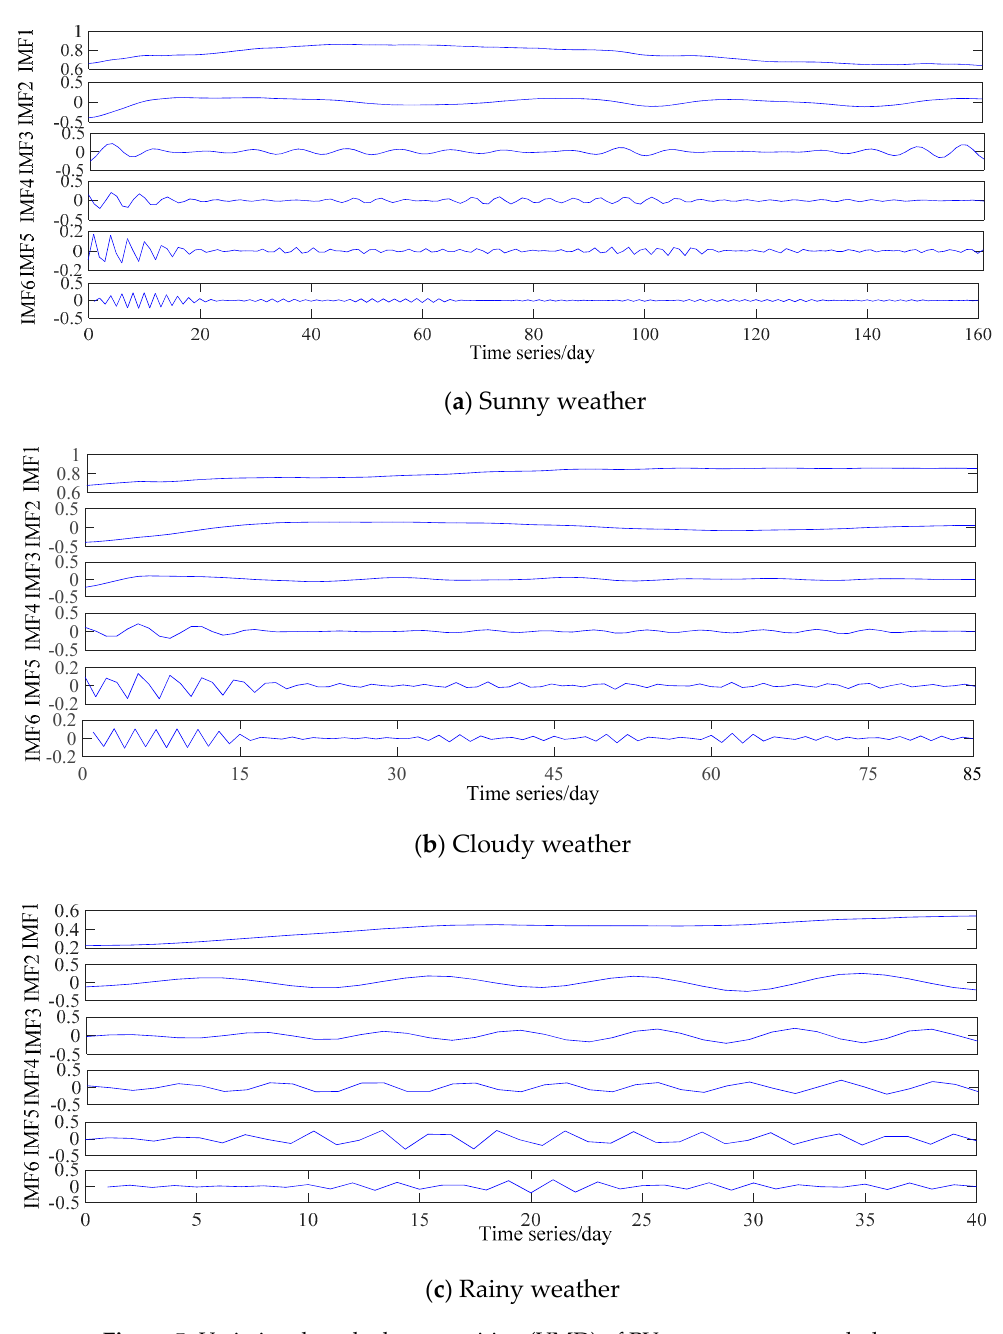
Figure 5. Variational mode decomposition (VMD) of PV power at noon each day.